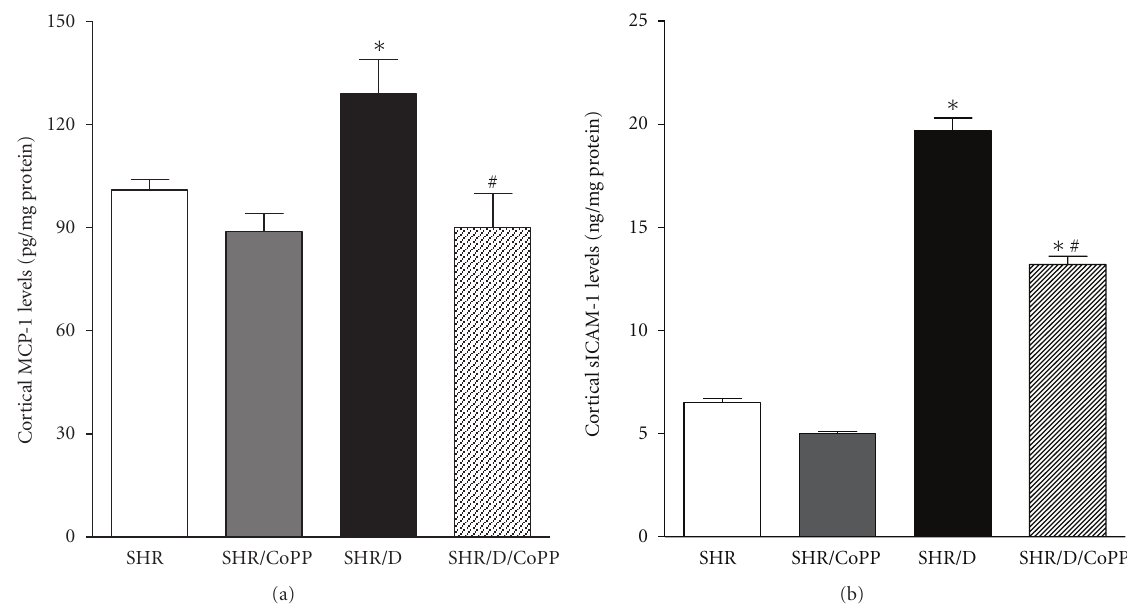
Figure 6: Renal cortical MCP-1 (a) and sICAM-1 (b) levels in control and diabetic SHR with or without CoPP treatment ( n = 8, ∗ indicates significant di ff erence from control SHR, # indicates significant di ff erence from diabetic